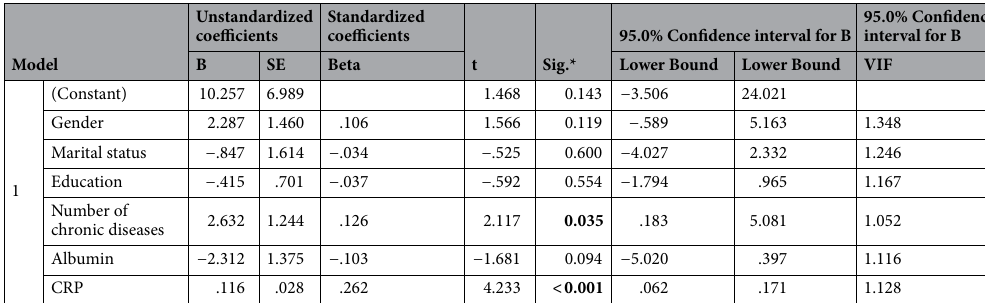
Table 5. Multivariate linear regression analysis of the pain severity score. a. Dependent Variable: pain severity. *The bold p value indicates that < 0.05, which considers significantly.